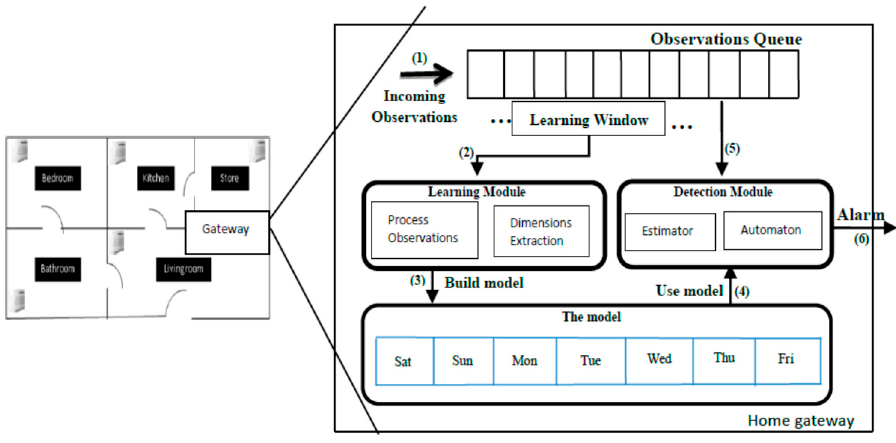
Figure 1. BMS system architecture.